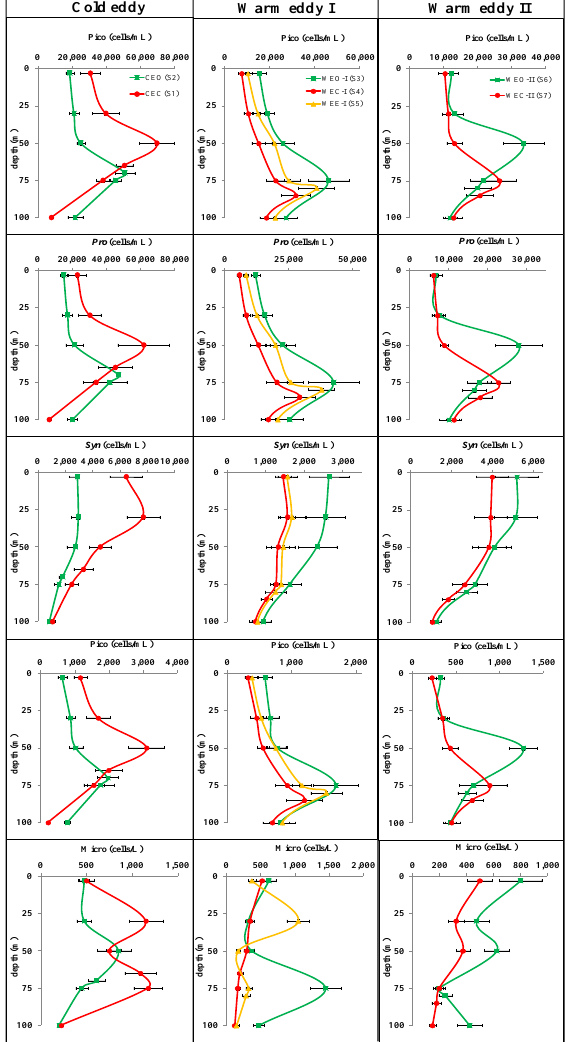
Figure 6. Comparison of the profiles of the phytoplankton community within the upper ocean (100 m) layer.